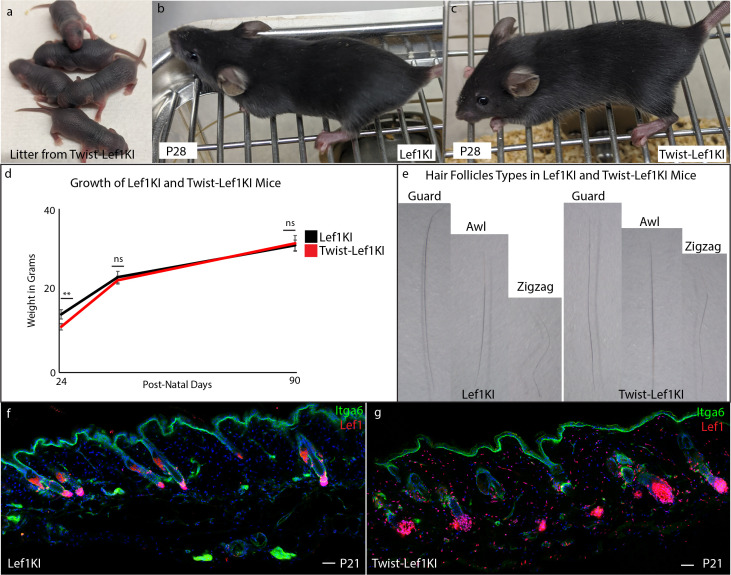
Twist-Lef1KI mice does not show overt phenotypic variations.(a) Images of P4 litter from Twist-Lef1KI mice revealing viability of line. (b–c) P28 of wild type (b) and Twist-Lef1KI (c) mice. (d) The growth curve of male WT (Lef1KI) mice (24 male mice total) compared to Twist-Lef1KI (15 male mice total) mice at P24, P40, and P90. P24 p<0.005. (e) Macroscopic images of different hair follicle types from WT (Lef1KI) and Twist-Lef1KI hair follicles. (f–g) Immunostaining analysis of sections from P21 skin from WT (Lef1KI) and Twist-Lef1KI mice stained for Itga6 and Lef1. Scale bars are 100 μm.